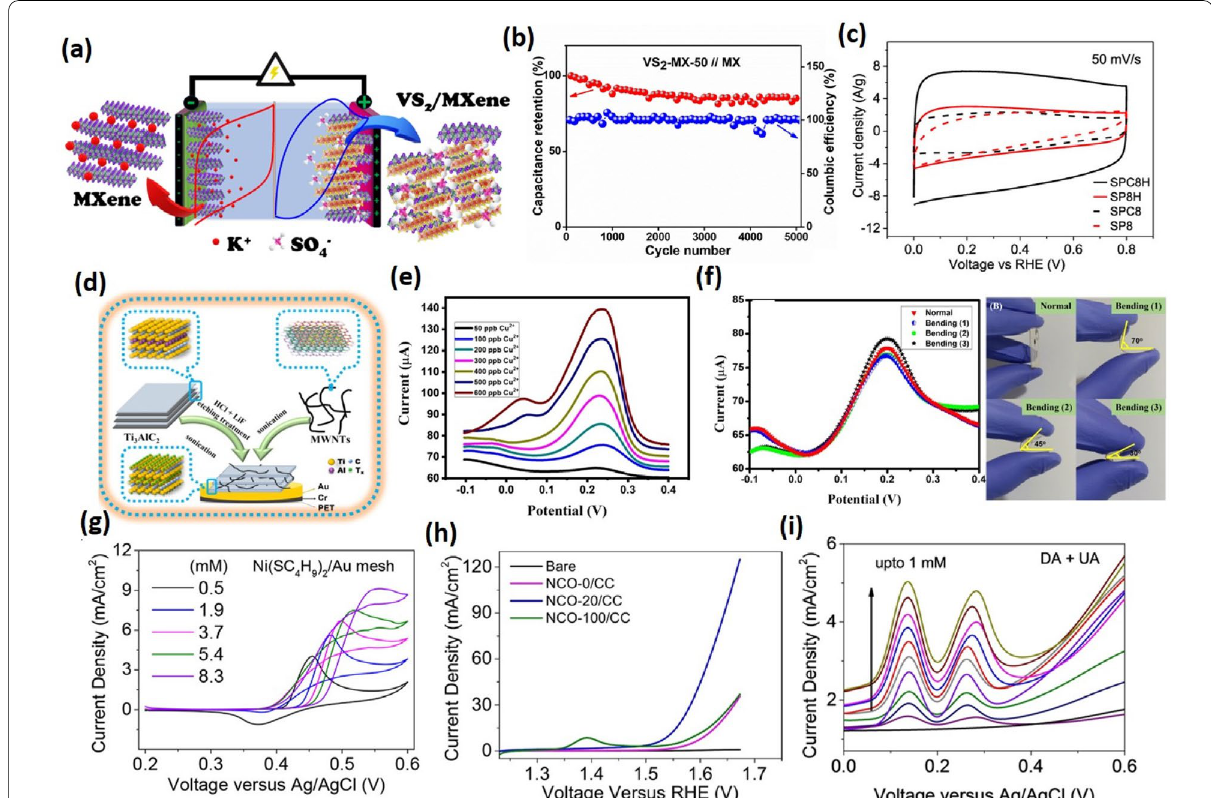
Fig. 5 a Schematic representation of charge transfer and storage mechanism of the VS 2 -MX-50//MXene asymmetric device b Cyclic Stability (85%) and Coulombic Efficiency ( 100%) of the VS 2 -MX-50//MX asymmetric device at a current density of 30 A/g. Figure adapted from reference [66] ∼ c Cyclic Voltammograms at a scan rate of 50 mV/s in the graphitic carbon electrodes. Figure adapted from reference [76] d Modification process of the flexible Ti3C2Tx/MWNTs/Au/PET working electrode. e SWASV responses of the Ti3C2Tx/MWNTs/Au/PET electrode for the determination of Cu(II) with various high concentrations in ABS (0.1 M, pH 4.6): 50 600 ppb. f SWASV responses of the Ti3C2Tx/MWNTs/Au/PET electrode for the − determination of 300 ppb Cu(II) in normal and different bending states and display of different bending processes of the fabricated electrode. Figure adapted from ref. [84] ( g ) Cyclic Voltammogram of Ni-C4SH/Au mesh as working electrodes in the glucose of different concentrations at a scan rate of 50 mV s − 1 Figure adapted from ref [85] ( h ) LSV curves at 5 mV/s of Ni-Co oxide nanoplate Figure adapted from ref. [86] ( i ) Simultaneous measurements with increasing concentration of equimolar Dopamine and Uric Acid from 1 nM to 1000 μM, respectively (Figure adapted from ref